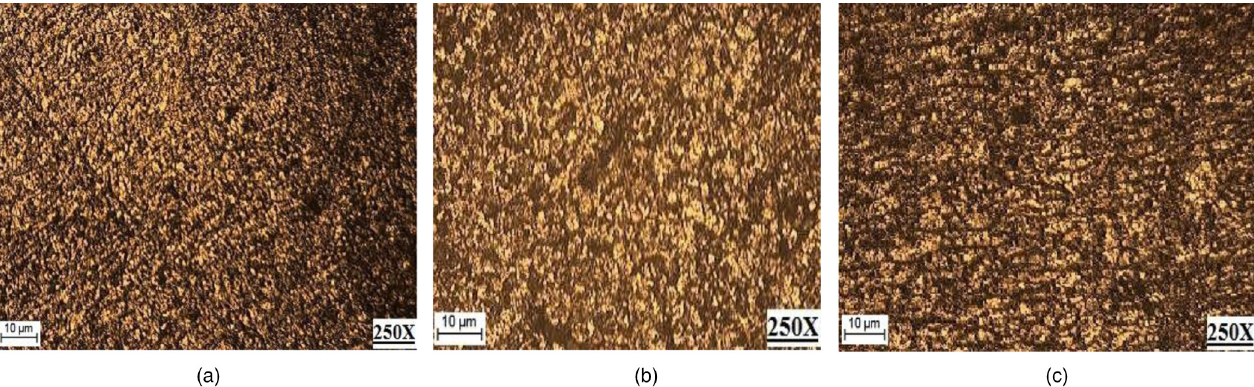
Fig. 5. Grain structure of 8 mm Tin castings for interior, middle as well as external surfaces for speeds of 1050 rpm. (a) 1050 rpm interior surface. (b) 1050 rpm middle surface. (c) 1050rpm external surface.